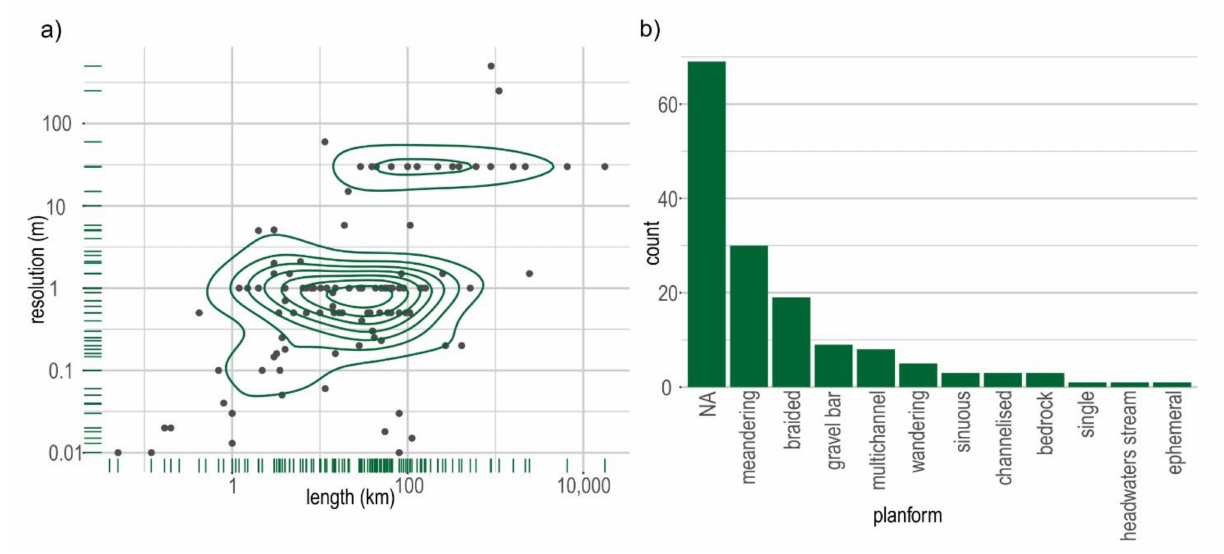
Figure 4. Relationship between sensor resolution and channel length ( a ) and a number of different river planforms ( b ) studied in the publications obtained from the WOS search. For most publications, the channel type was not explicitly mentioned and was marked as